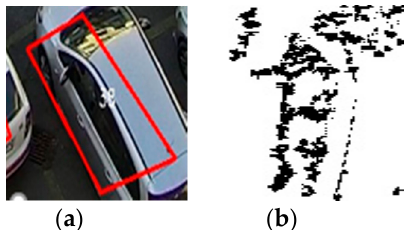
Figure 6. The image of ( a ) occupied parking space); ( b ) the result of SIFT corner detector. Future Internet 2019 , 11 ,